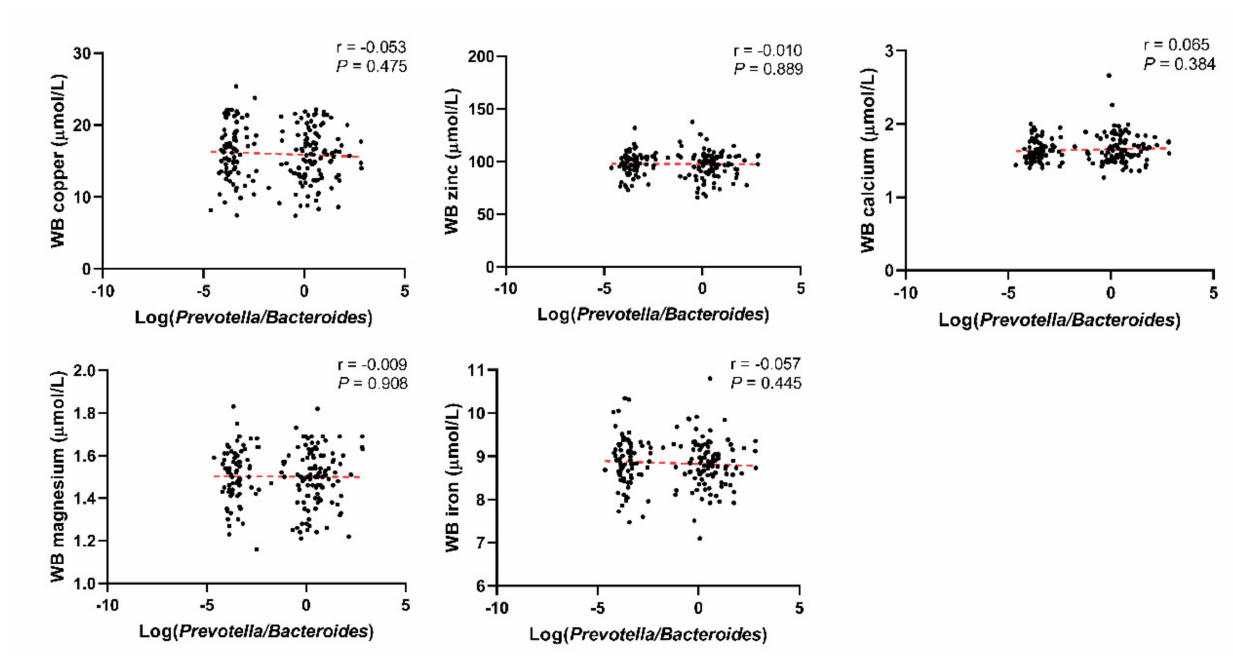
Figure 4. Correlation between Log( P/B ) and whole blood copper, zinc, calcium, magnesium, and iron levels among control group. Log( P/B ), Log-normalized Prevotella-to-Bacteroides; WB, whole